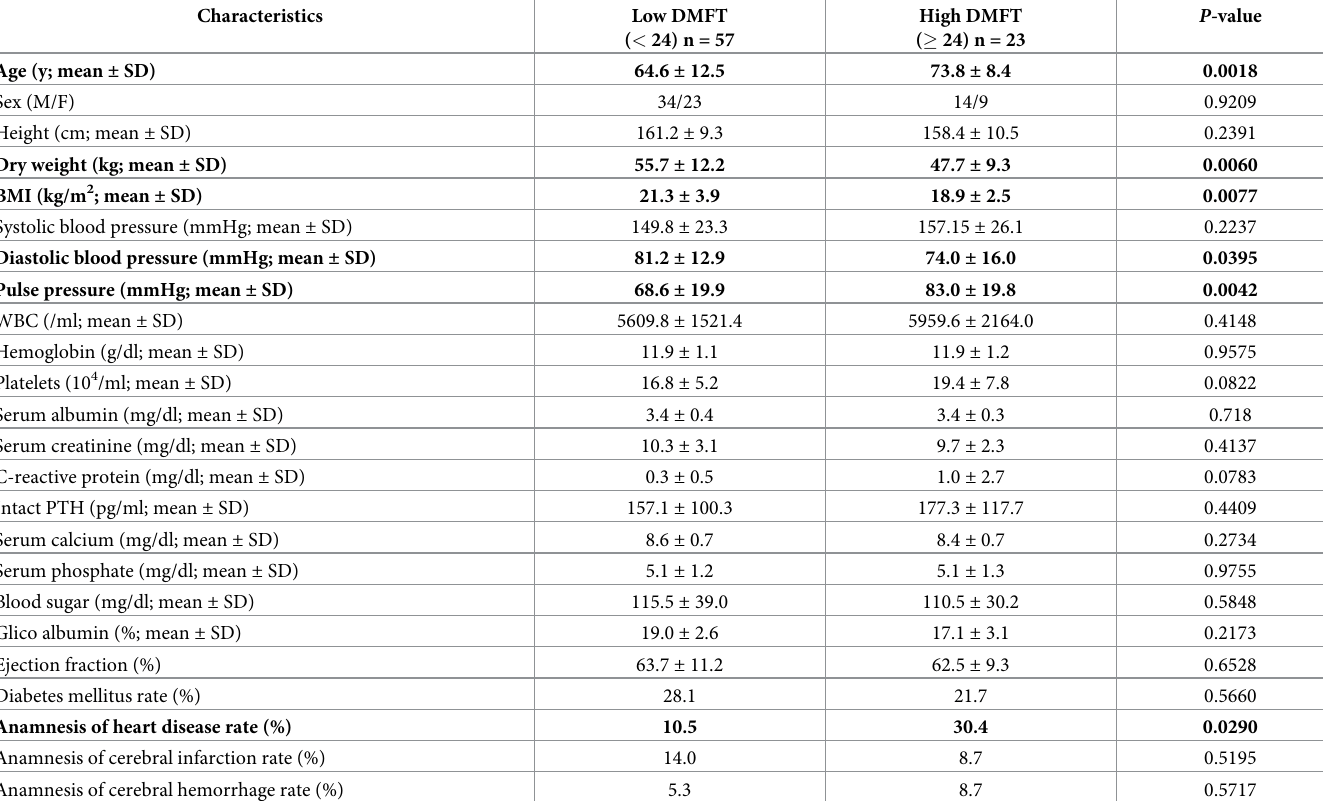
Bold values indicate statistical significance at p < 0.05. BMI: body mass index. DMFT scores: the numbers of total, decayed (DT), missing (MT), and filled (FT) teeth, intact PTH: intact parathyroid hormone, WBC: white blood